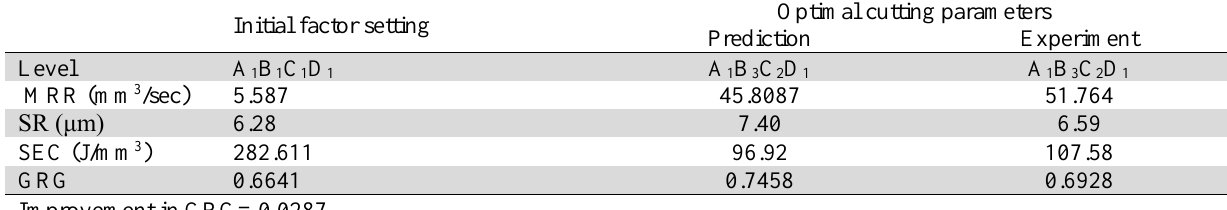
Results of the confirmatory experiment for GRA method Initial factor setting